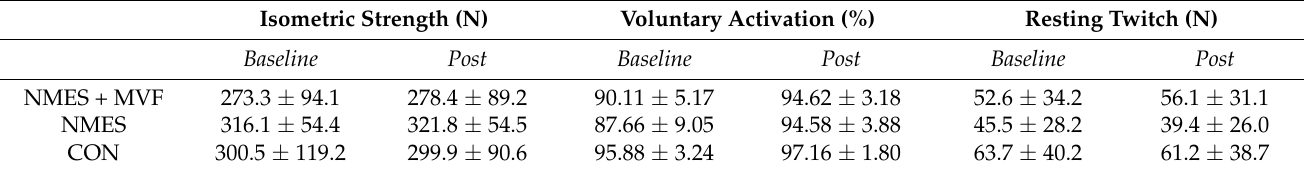
Table 1. Mean and standard deviation (SD) for the isometric strength, voluntary activation level, and resting twitch of the non-dominant (untrained) elbow flexor muscle for all groups. Isometric Strength (N)